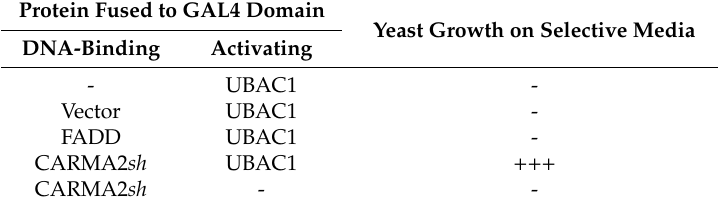
Table 1. Interaction of CARMA2sh with UBAC1 in the yeast two-hybrid assay. Yeast AH109 was transformed with CARMA2sh fused to the GAL4-DNA binding domain together with the indicated cDNAs fused to GAL4-activating domain. The cDNA encoding for FADD was used as a putative negative control. Interactions were examined by yeast growth on selective media; assays were done for ten independent transformants. Yeast colonies were scored as positive ( + ) when a growth developed within 36 h; a negative (-) was scored when growth failed to develop within 5